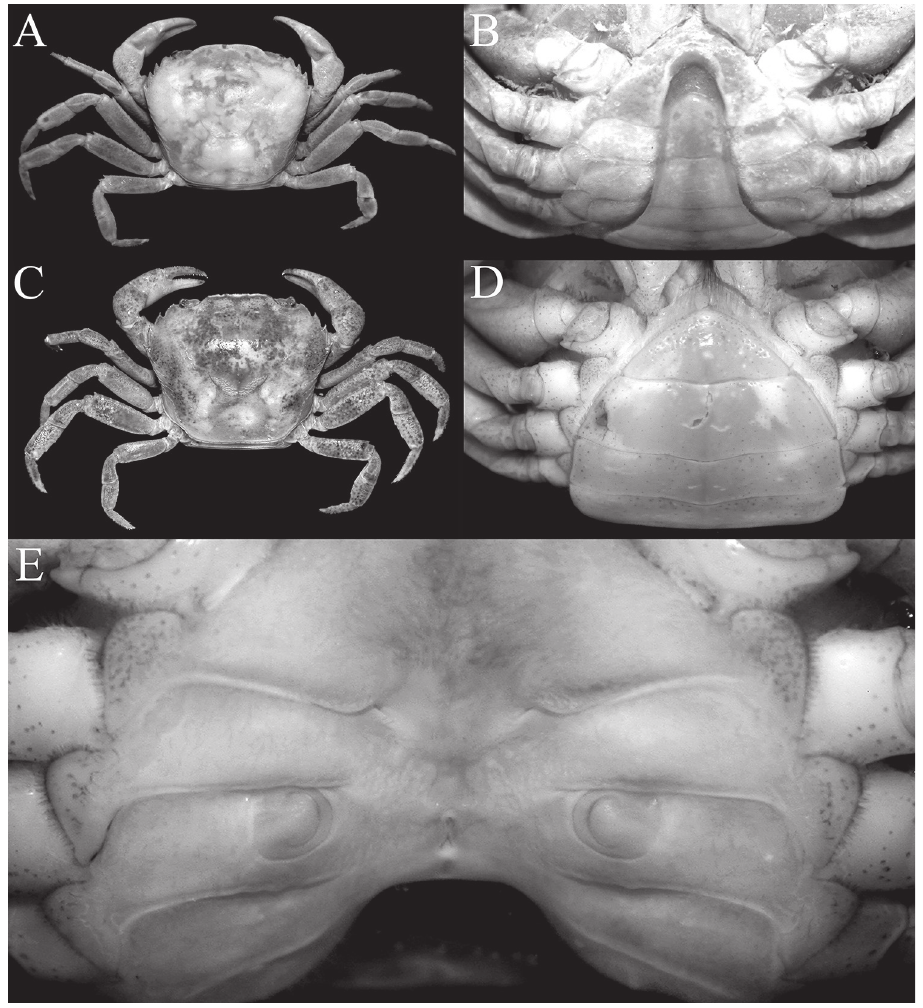
Figure 4. Salangathelphusa peractio sp. n. A , B paratype male (12.0 × 10.6 mm) (ZRC 2017.209), Langkawi C , D paratype female (21.7 × 17.3 mm) (ZRC 2017.210), Langkawi. A , C overall habitus B male anterior thoracic sternum and pleon D female anterior thoracic sternum and pleon E female sternopleonal cavity showing